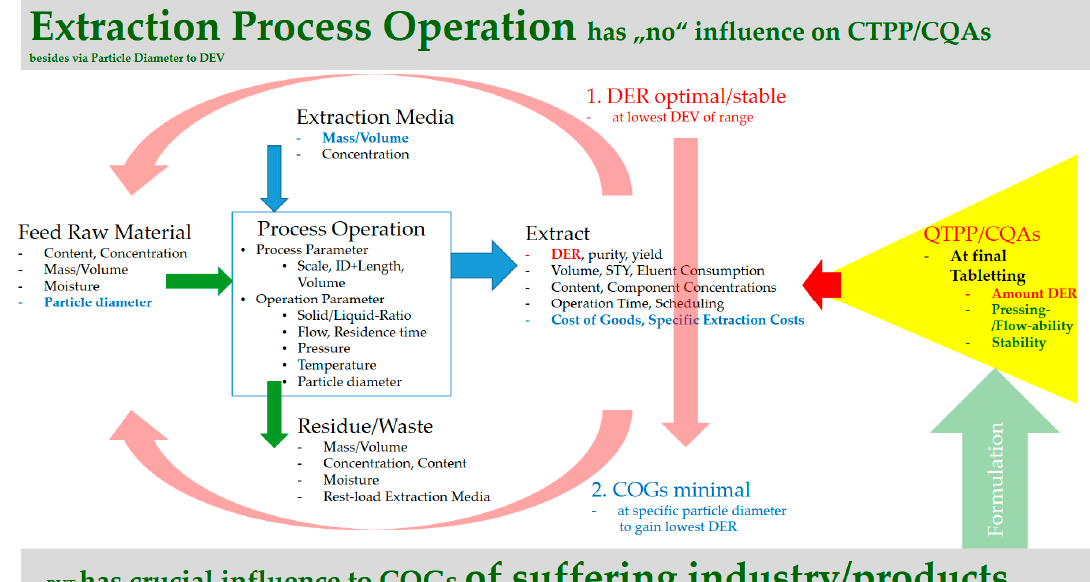
Figure 5. Analysis of root cause for Qbd-approach derived critical product quality attributes effects during manufacturing.